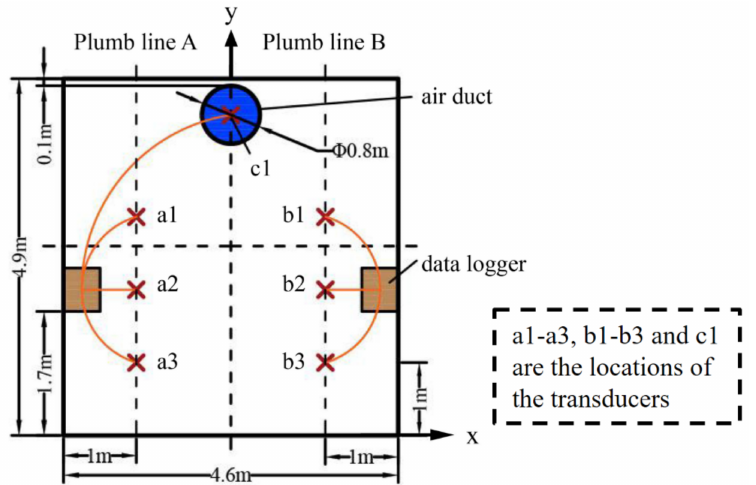
Figure 4. Cross section of the airway that illustrates the installation of data loggers and transducers.